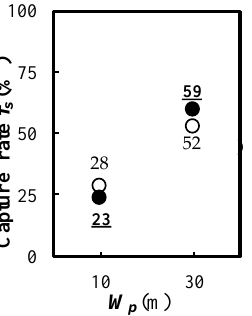
Figure 21. Comparison of the experimental results and the numerical analysis results for changes in the width of the sediment retarding basin.